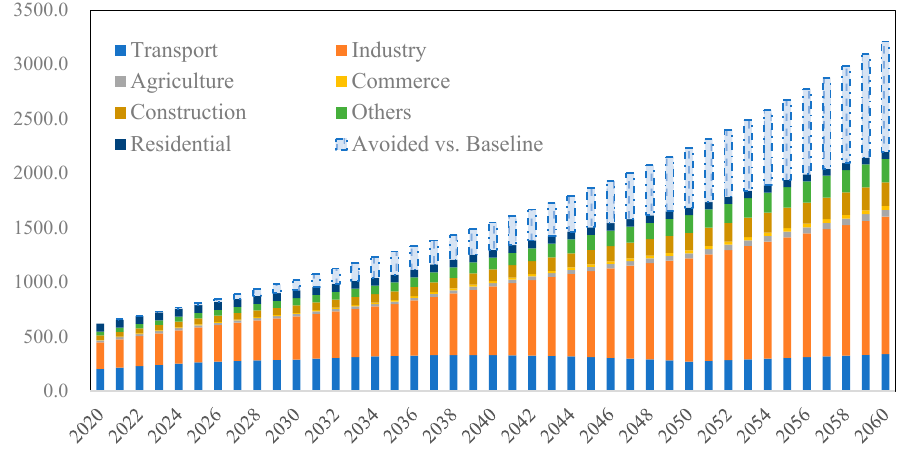
Figure 10. Petroleum products demand under sub-scenario 1 and the changes relative to baseline.